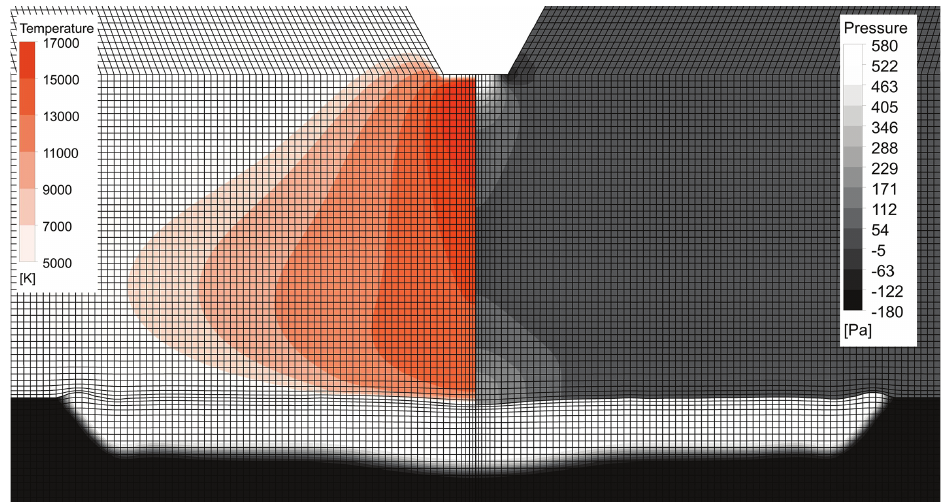
Figure 11: Temperature pro- file, pressure field and weld pool shape predicted by the interface